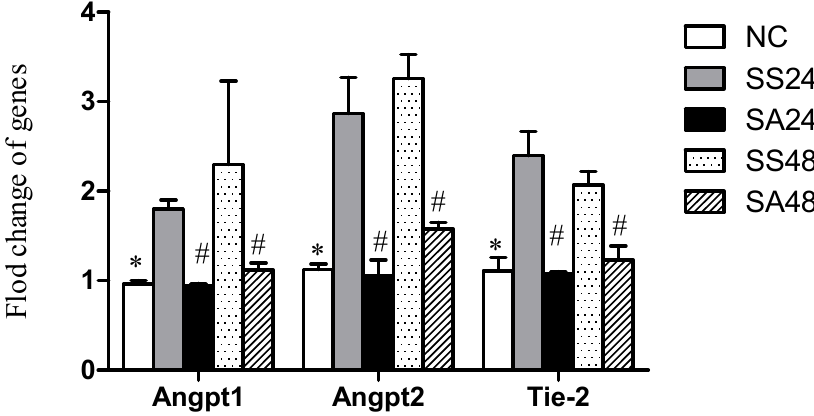
Figure 2. Expression of angiopoietin1 (Angpt1), Angpt2, and Tie-2 mRNAs in lung tissues. NC, normal control group; SS24, sepsis at 24 h with saline; SA24, sepsis at 24 h with arginine; SS48, sepsis at 48 h with saline; SA48, sepsis at 48 h with arginine. Data are presented as the mean ± SD. * Significantly differs from the sepsis group. # Significantly differs from the SS group at the same time point ( p < 0.05).